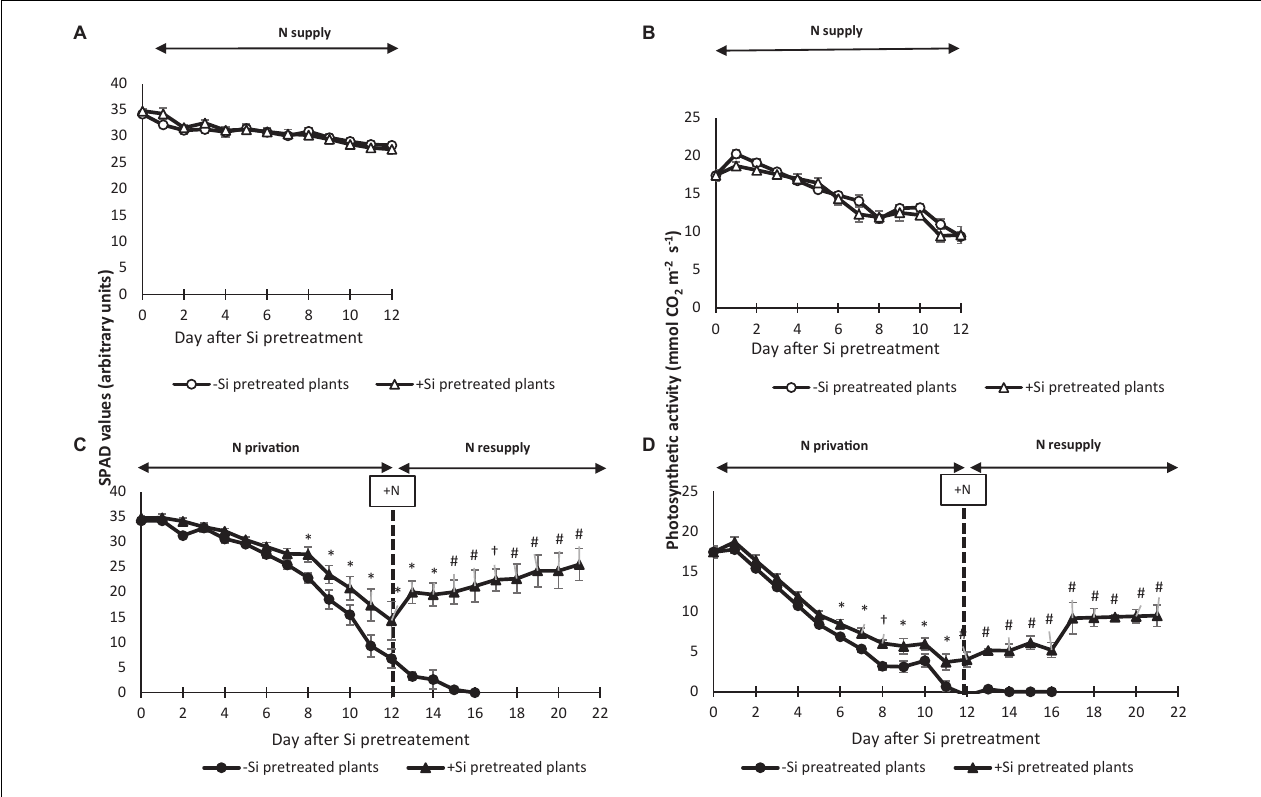
IP contents is significantly higher in mature leaf of + Si − N plants (1.9-fold; Figure 6D ) than in mature leaf of − Si − N while other cytokinin contents [i.e., trans -zeatin and N 6 - Isopentenyladenosine (IPAdo)] remain at the level whatever